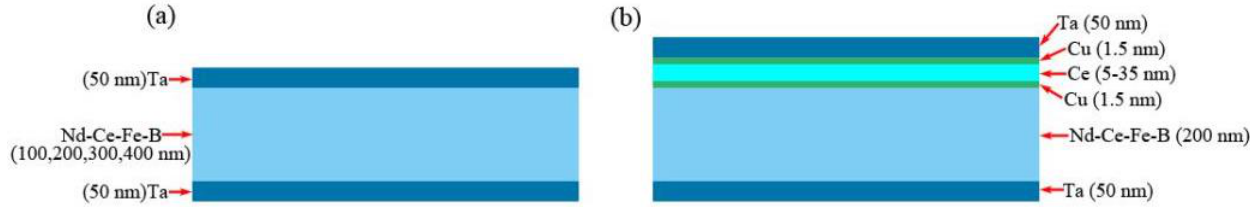
Figure 1. The schematic diagram of multilayer films prepared in this work. ( a ) Ta (50 nm)/Nd-Ce-Fe-B (t NdCeFeB nm)/Ta (50 nm) film. ( b ) Ta (50 nm)/Nd-Ce-Fe-B (200 nm)/Cu (1.5 nm)/Ce (t Ce nm)/Cu (1.5 nm)/Ta (50 nm) film.